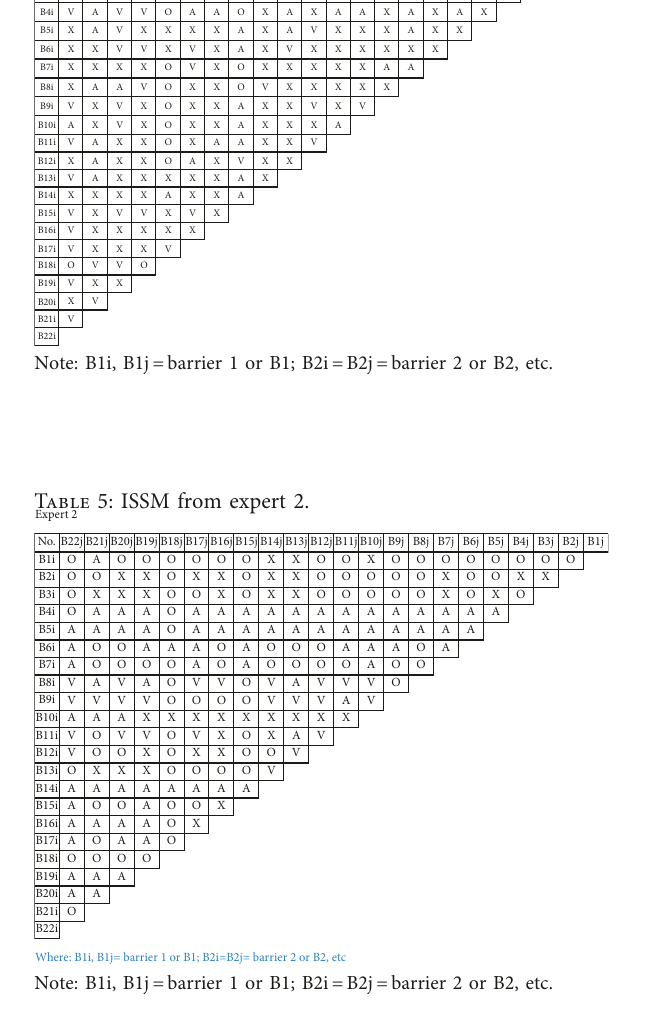
Where: B1i, B1j= barrier 1 or B1; B2i=B2j= barrier 2 or B2, Note: B1i, B1j � barrier 1 or B1; B2i � B2j � barrier 2 or B2,